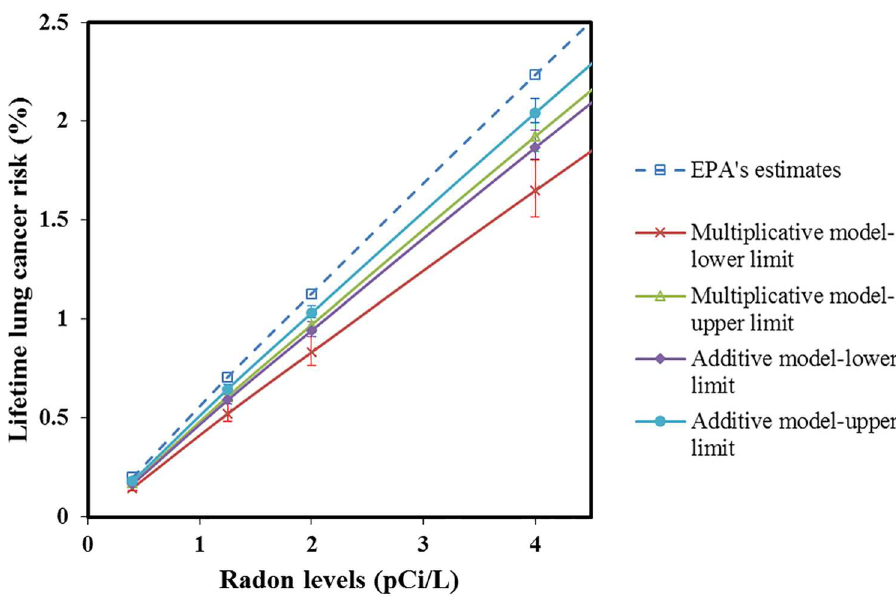
Fig 2. Modified EPA’s estimatesof the lifetime lung cancer risks at various indoor radon exposure levels compared to EPA’s original estimate.